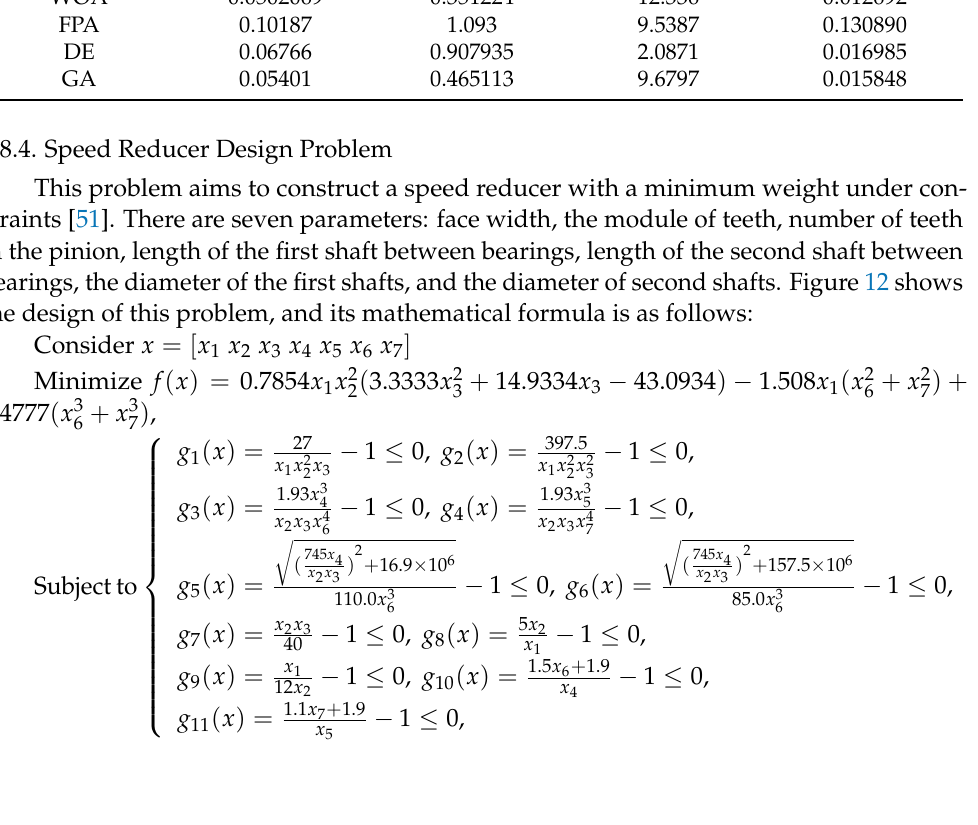
The statistical results of the tension spring design problem were obtained by HAGSA